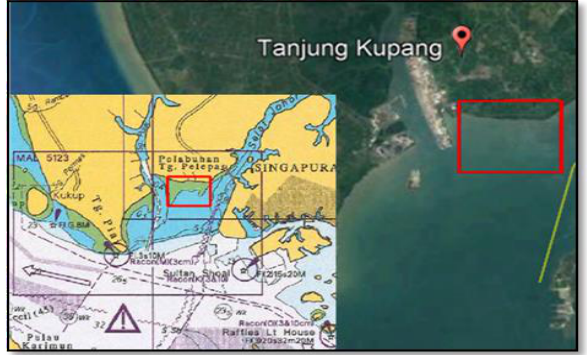
Figure 3. The study area of Tanjung Kupang at Strait of Johor.